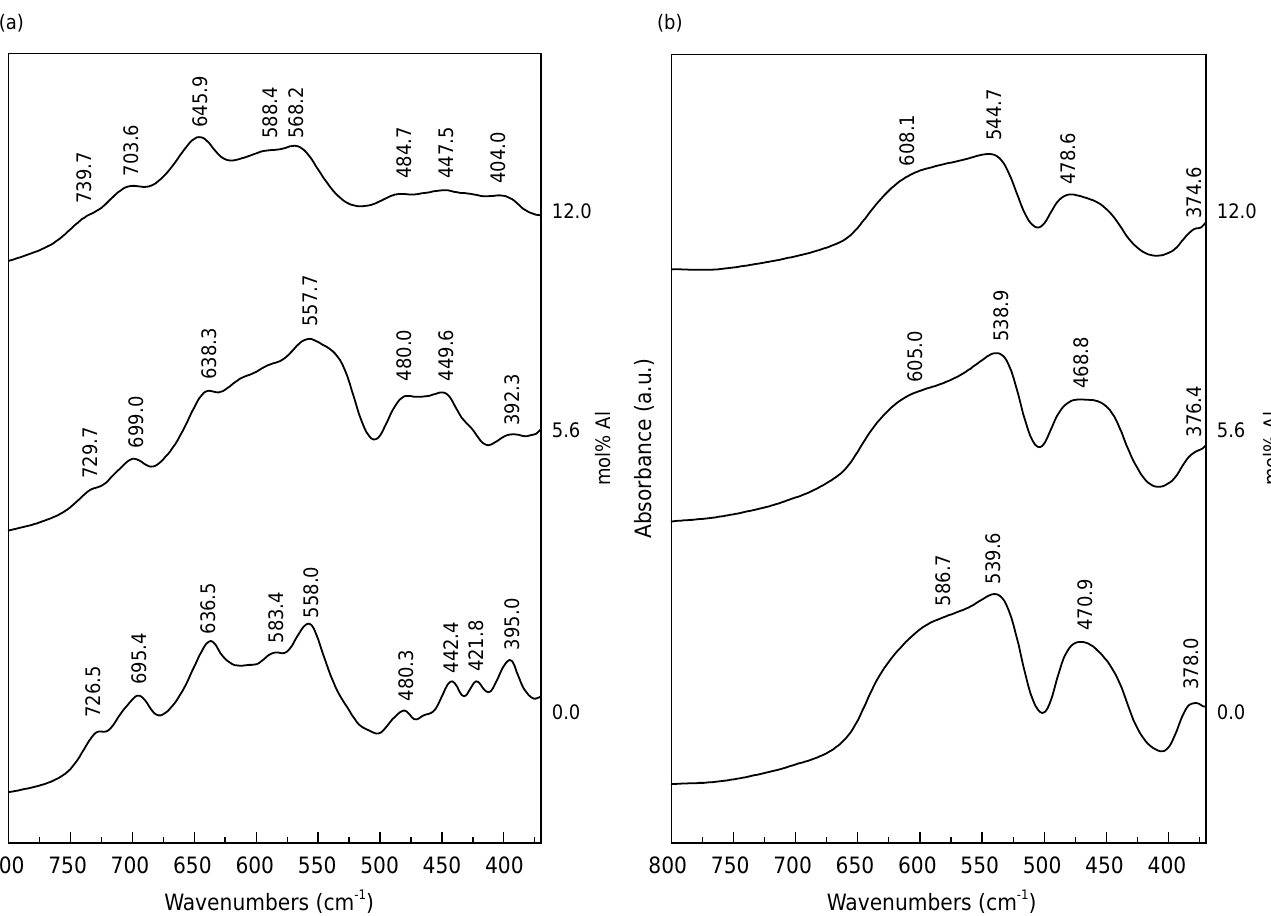
Figure 7. FTIR spectra of synthetic Al-substituted maghemite (a) and Al-hematite (b) in the range 370 - 800 cm -1 . a.u.: arbitrary unit.